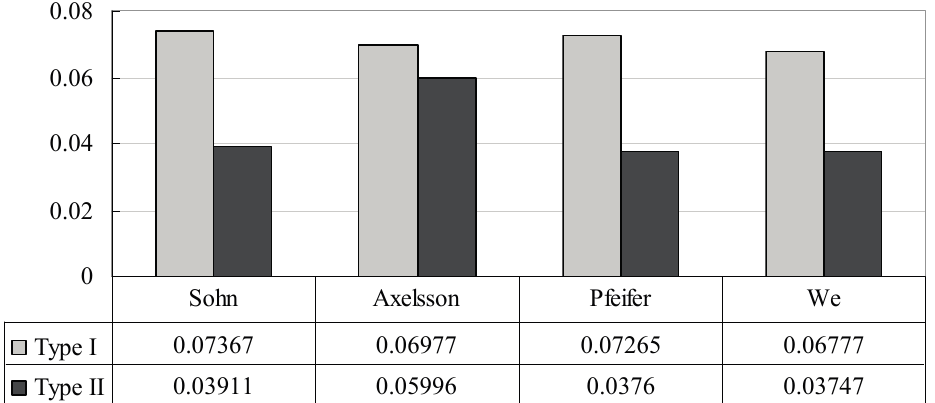
Figure 9. Standard deviations of errors produced by different